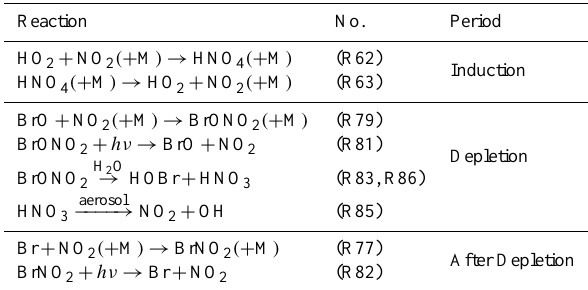
Fig. 10. Temporal evolution of NO x -relevant reaction rates for a 200m boundary layer height: (a) formation, (b) depletion. Table 5. Overview of NO x -relevant reactions and periods.